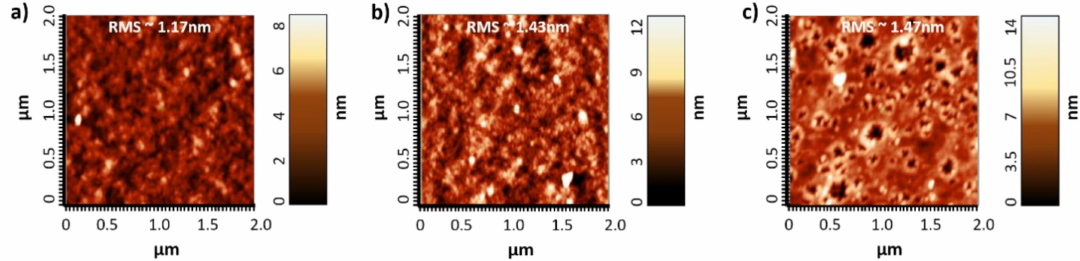
Figure 5. Atomic force microscopy (AFM) images of thin films. ( a ) PTB7-Th and ITIC blend, ( b ) PFN upon PTB7-Th and ITIC blend, ( c ) NDI-OH upon PTB7-Th and ITIC